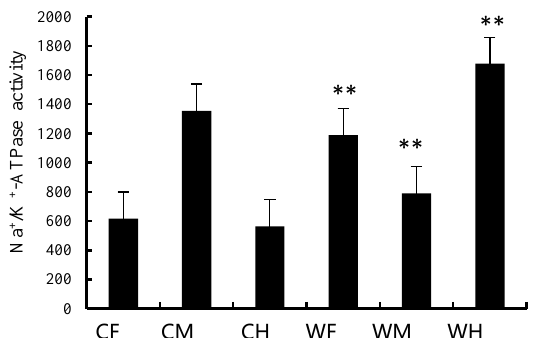
Figure 3. The vitality of Na + /K + -ATPase in cultured and wild Hemibarbus maculatus. The activity of Na + /K + -ATPase in the wild foregut and hindgut was significantly higher than that of the cultured group, while was significantly higher in the midgut of the cultured than that of the wild group. Note: n = 30, the data were misrepresented by average ± standard deviation ** indicates that the data were significantly different from those of cultured (wild) ( p < 0.01).